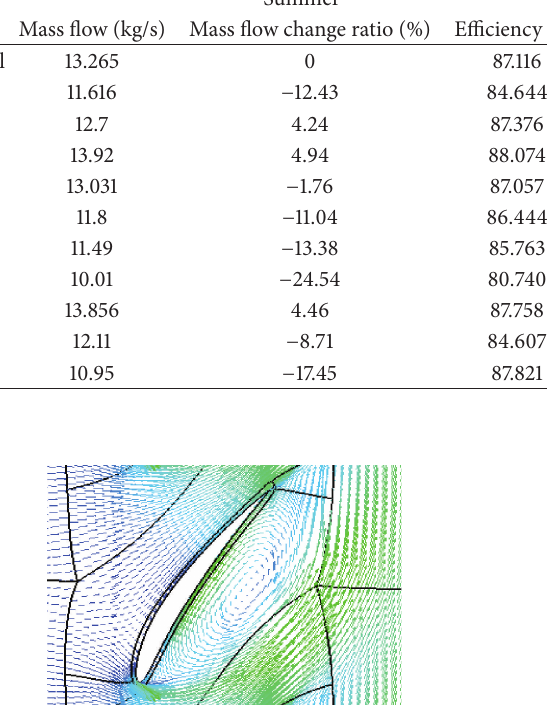
Figure 15: Velocity vector distribution of 6408 at 60 ∘ setting angle.